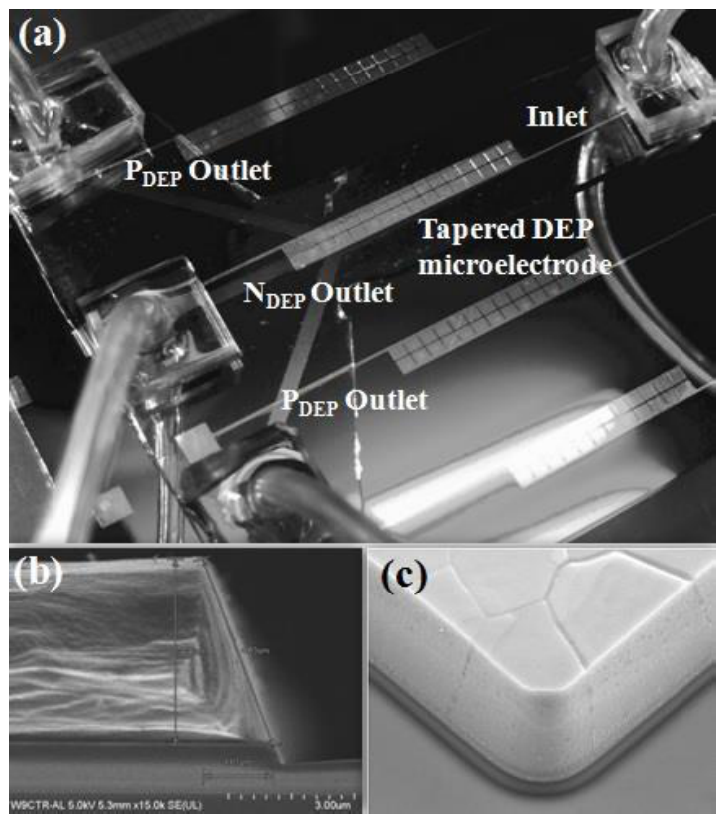
Figure 7. The tapered DEP microelectrode: ( a ) integration with one inlet and three outlet microchannels of ( b ) the side and ( c ) tilt views of the tapered profile angle 70 ° .